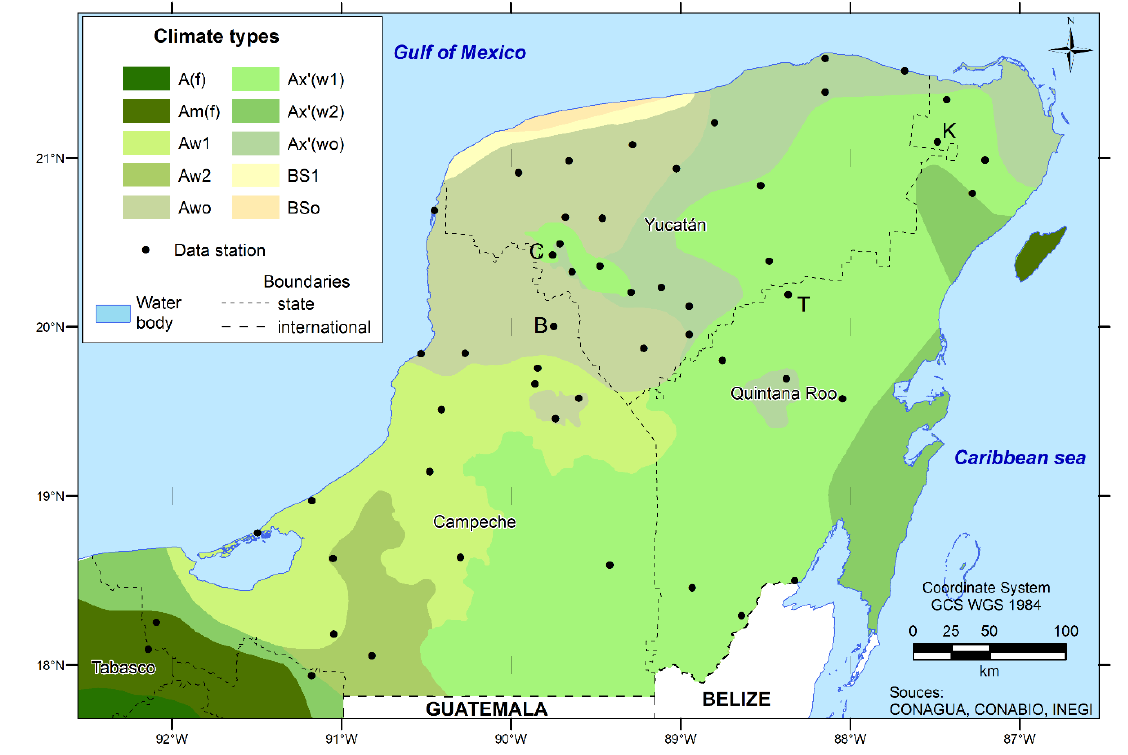
Figure 1. Climate types according with Köppen modified by Garcia system in the study area and location of data stations used (B: Bolonchen, C: CIAPY, T: Tihosuco and K: Kantunilkin). location of data stations used (B: Bolonchen, C: CIAPY, T: Tihosuco and K: